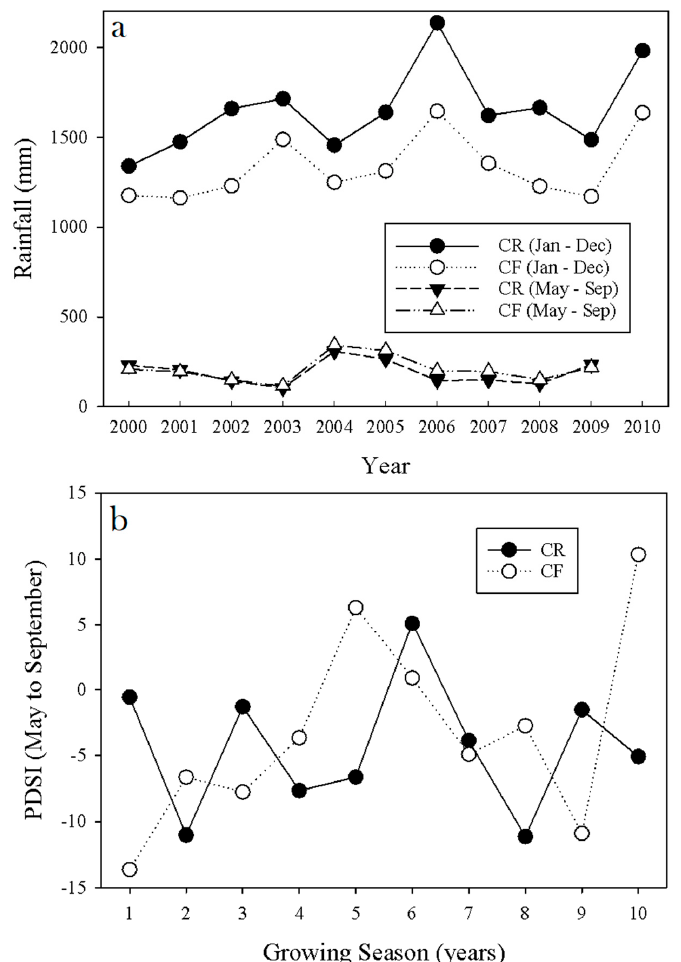
Figure 1. ( a ) Yearly rainfall and ( b ) Palmer drought severity index (PDSI) during growing period (between May and September) at the coast range site (CR, line with filled symbols) and the cascade foothill site (CF, line with open symbols) from 2000 to 2010. At the CR site, growing season 1 started in year 2000. At the CF site, growing season 1 started on year 2001.